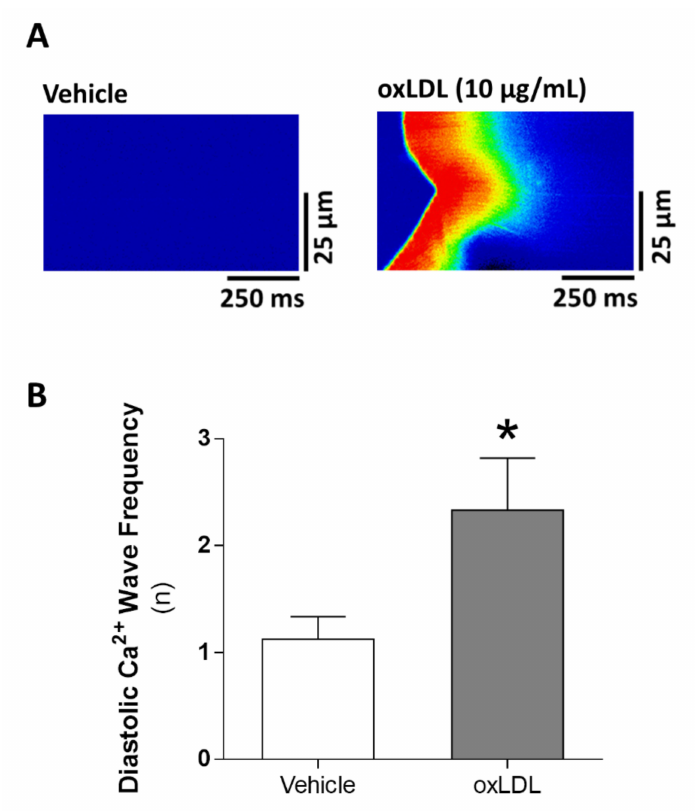
Figure 5. Pro-arrhythmogenic e ff ect of oxLDL in vitro. ( A ) Representative line-scan images of Ca 2 +